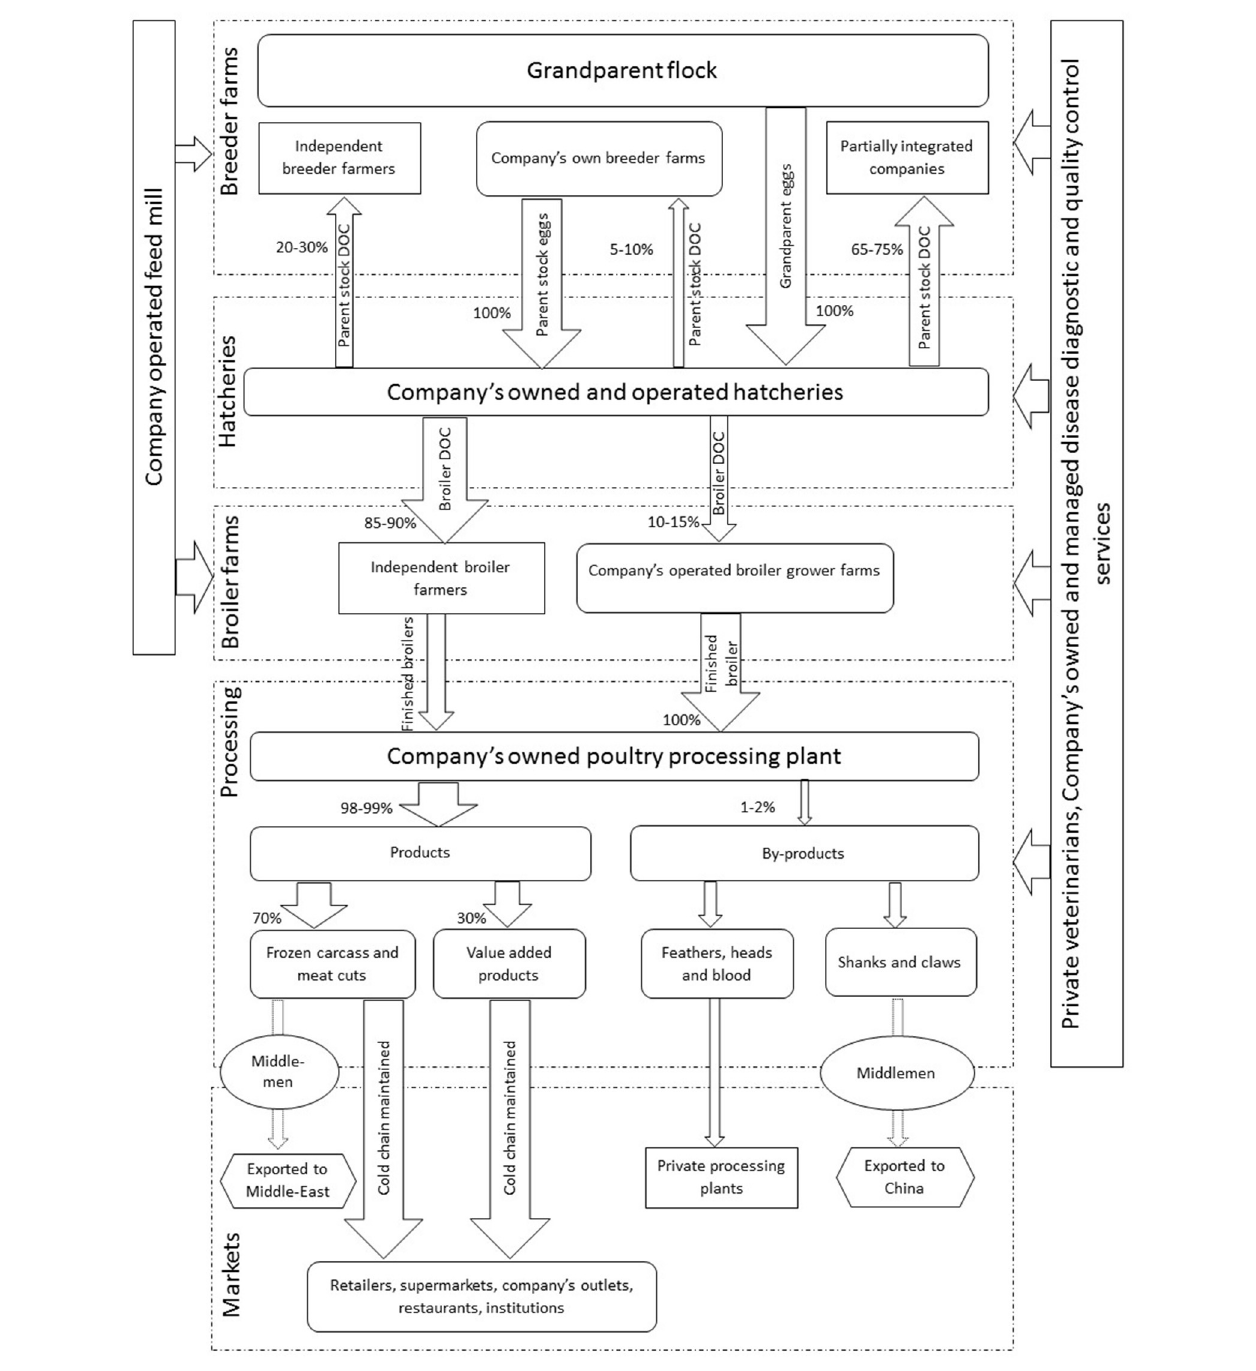
FIGURE 3 | Map of the fully integrated broiler production system with distribution chains and target markets. DOC indicates day old chicks, numbers in and around arrows and width of arrows indicate the market share. Dotted lines show the parts of chains operated by the middlemen.